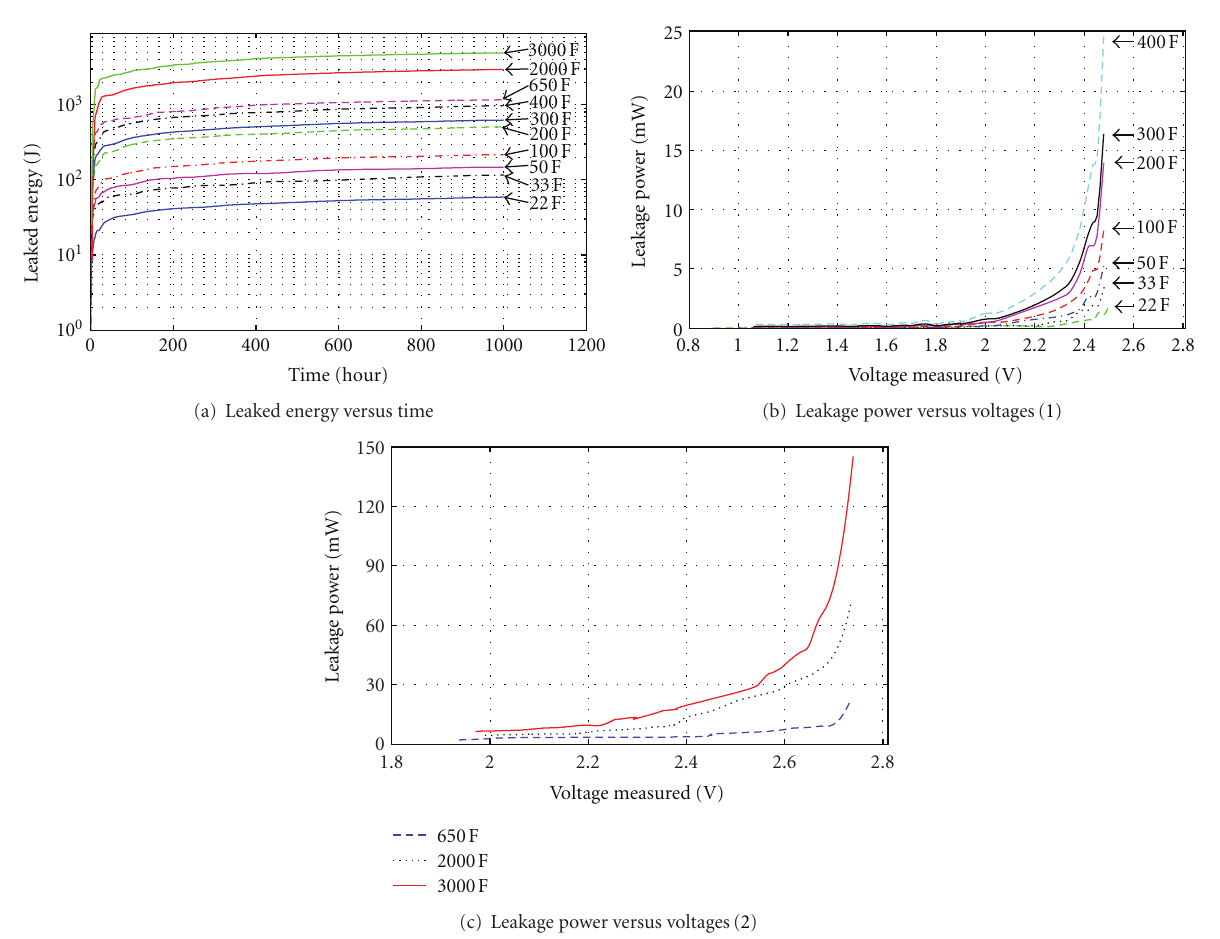
Figure 1: Leakage property of